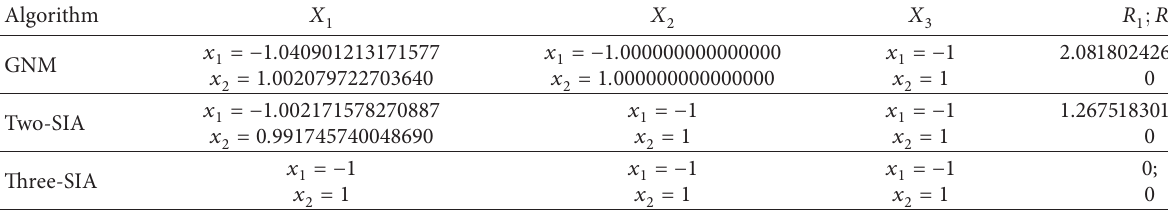
Table 1: The comparison of three-SIA, two-SIA, and GNM for Example 1.